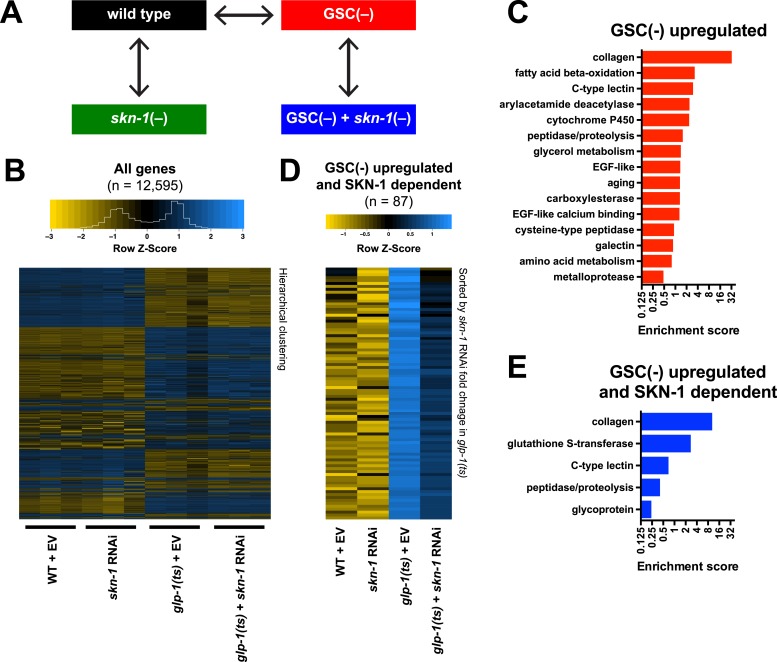
Effects of GSC absence and skn-1 on gene expression.(A) RNA-seq experiment setup. For each condition, three biological replicates were obtained from synchronized intact day-1 adults at 25°C. Arrows indicate comparisons that were made, and GSC(−) refers to glp-1(ts). (B) Heatmap of all genes evaluated, showing biological replicates. (C) DAVID functional annotation analysis of GSC(−)-upregulated genes. (D) Heatmap of genes upregulated in glp-1(ts) in a skn-1-dependent manner (87 genes; fold change (FC) > 4 in GSC(−); FC < 0.67 with skn-1 RNAi in GSC(−)). (E) Functional annotation of the genes shown in (D). Genes and additional statistics are provided in Supplementary file 1a,d.